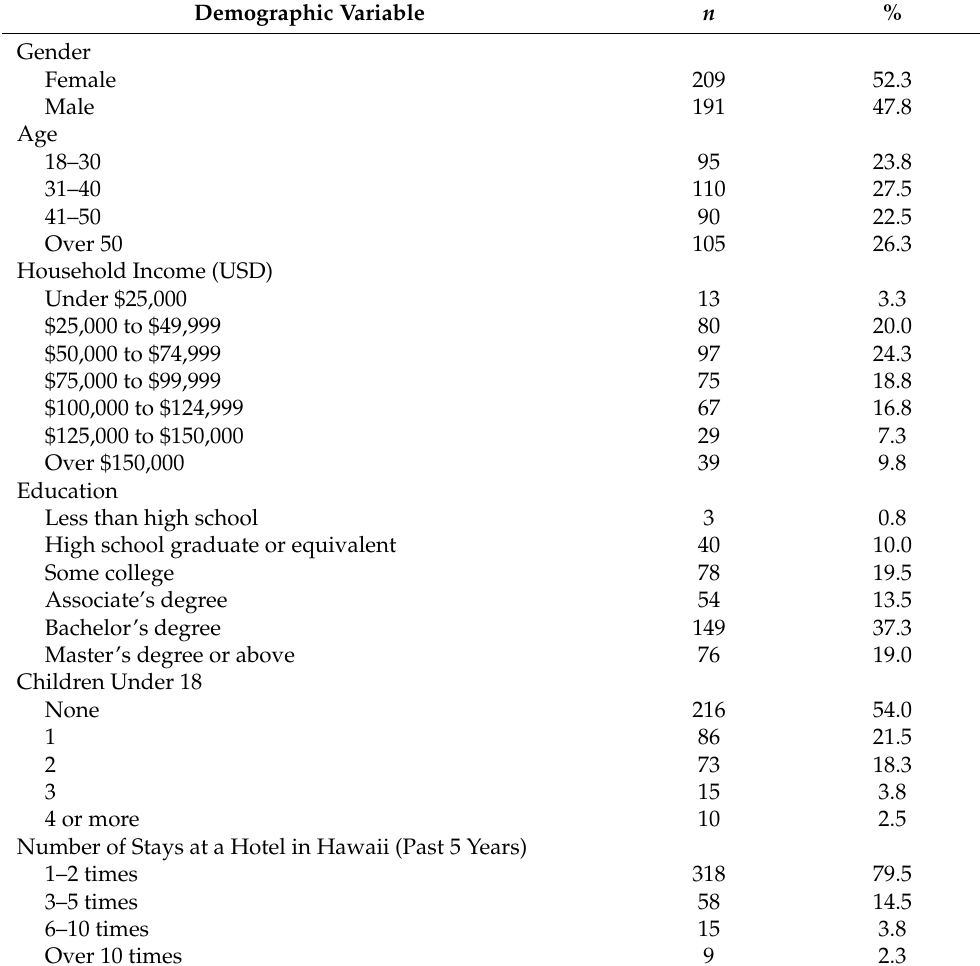
Table 2. Demographic profile of